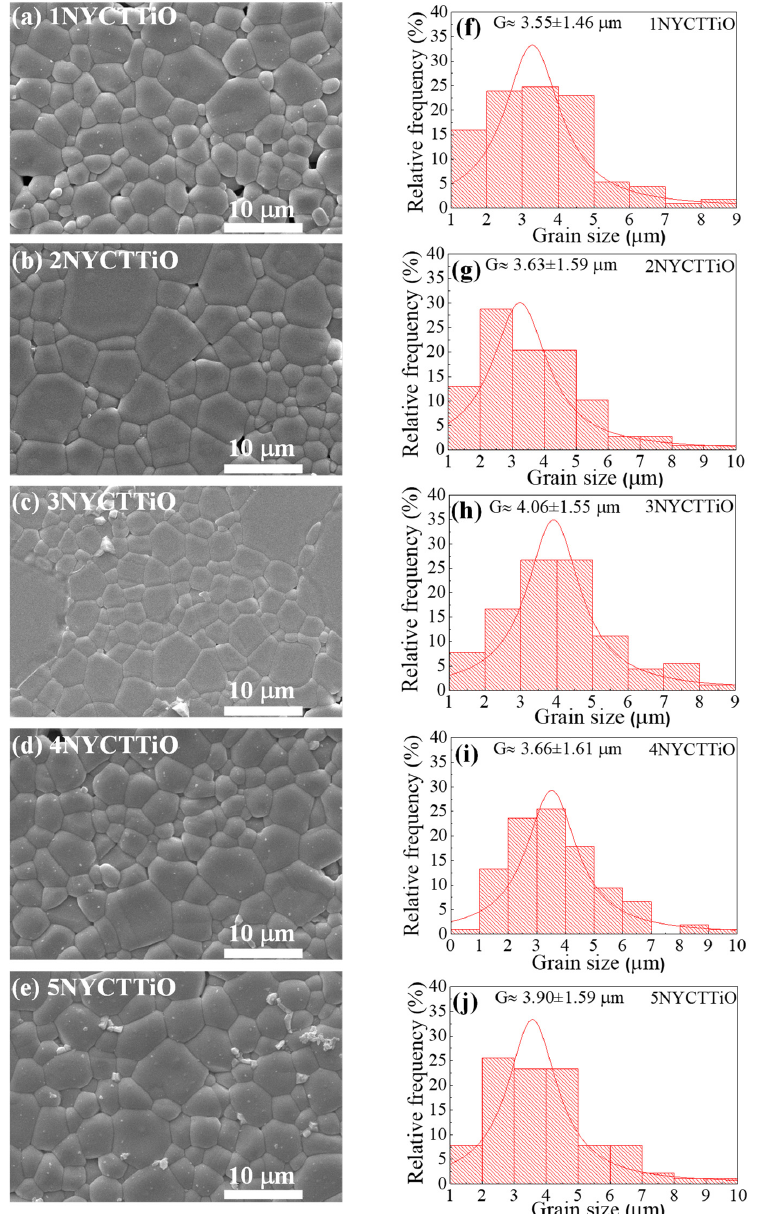
Figure 2. SEM images of polished surfaces of Na 1/2 Y 1/2 Cu 3 Ti 4.1 O 12 ceramics sintered at ( a ) 1070 °C for 1 h, ( b ) 1070 °C for 5 h, ( c ) 1070 °C for 15 h, ( d ) 1080 °C for 5 h, and ( e ) 1090 °C for 5 h and grain size distributions with sintering at ( f ) 1070 °C for 1 h, ( g ) 1070 °C for 5 h, ( h ) 1070 °C for 15 h, ( i ) 1080 °C for 5 h, and ( j ) 1090 °C for 5 h.